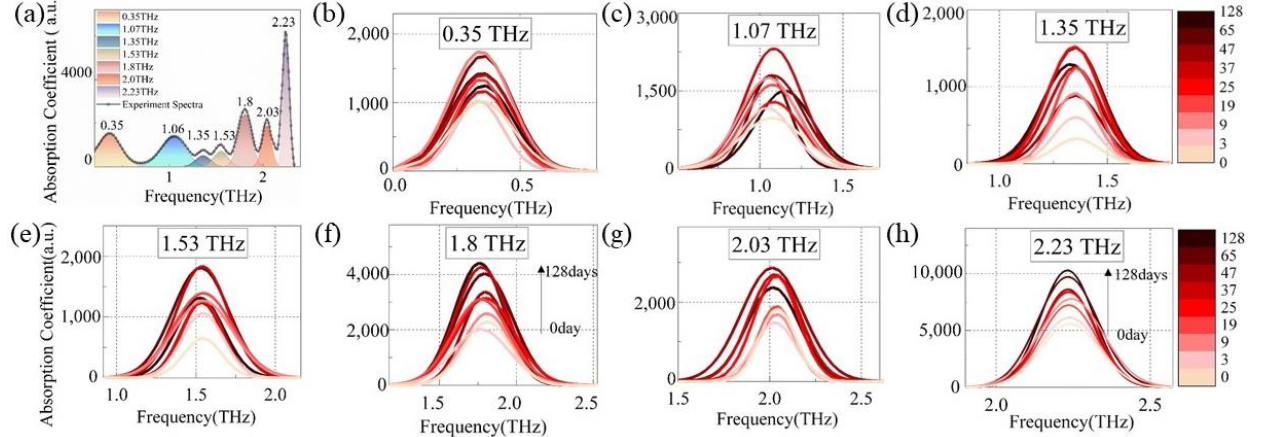
Figure 5. ( a ) Schematic diagram of the multi-peak fitting of the spectrum after baseline correction and the separated absorption peak curves at ( b ) 0.35 THz, ( c ) 1.07 THz, ( d ) 1.35 THz, ( e ) 1.53 THz, ( f ) 1.8 THz, ( g ) 2.03 THz, and ( h ) 2.23 THz.